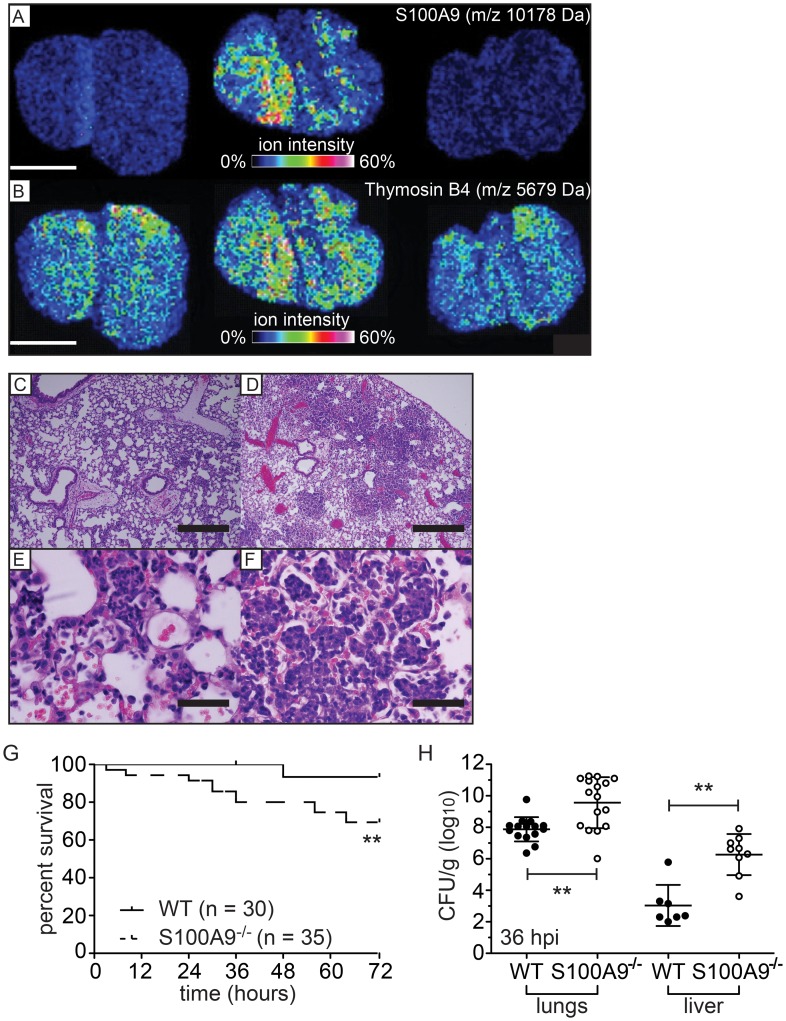
CP contributes to protection against A. baumannii infection.(A–B) IMS detection of host proteins in lungs harvested at 36 hpi with A. baumannii. Scale bar = 2 cm. (A) Heat map demonstrating the distribution and abundance of S100A8 (m/z = 10,165.8±5 Da) in uninfected wildtype (left) and infected wildtype (middle) or S100A9−/− (right) mice. (B) Heat map demonstrating the distribution and abundance of a protein exhibiting m/z 5,679±5 Da in uninfected wildtype (left) and infected wildtype (middle) or S100A9−/− (right) mice. (C–F) Hematoxylin and eosin stained histological sections taken from lungs harvested at 36 hpi from mice infected with A. baumannii. (C, E) Wildtype C57BL/6. (D, F) S100A9−/−. Scale bars equal 500 µm (C–D) and 50 µm (E–F). Images are representative of sections taken from three mice for each genotype. (G) Survival of wildtype or CP-deficient mice following infection with A. baumannii. Data were combined from three independent experiments with 8–16 mice per group in each experiment. ** p<0.01 as determined by Gehan-Breslow-Wilcoxon Test. (H) Bacterial burden in lungs and livers of wildtype or CP-deficient mice 36 hpi with A. baumannii. Data were averaged from three independent experiments with 5–10 mice per group in each experiment. ** p<0.01 as determined by Student's t test.